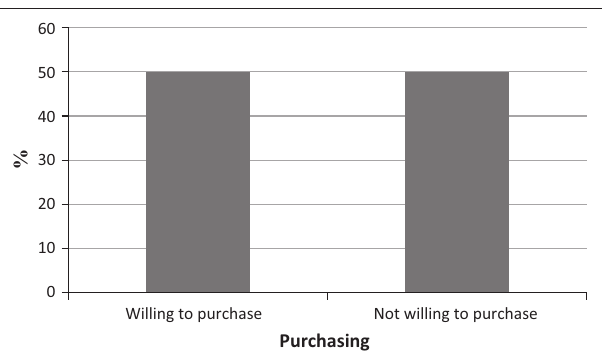
FIGURE 10: Willingness to purchase an application providing